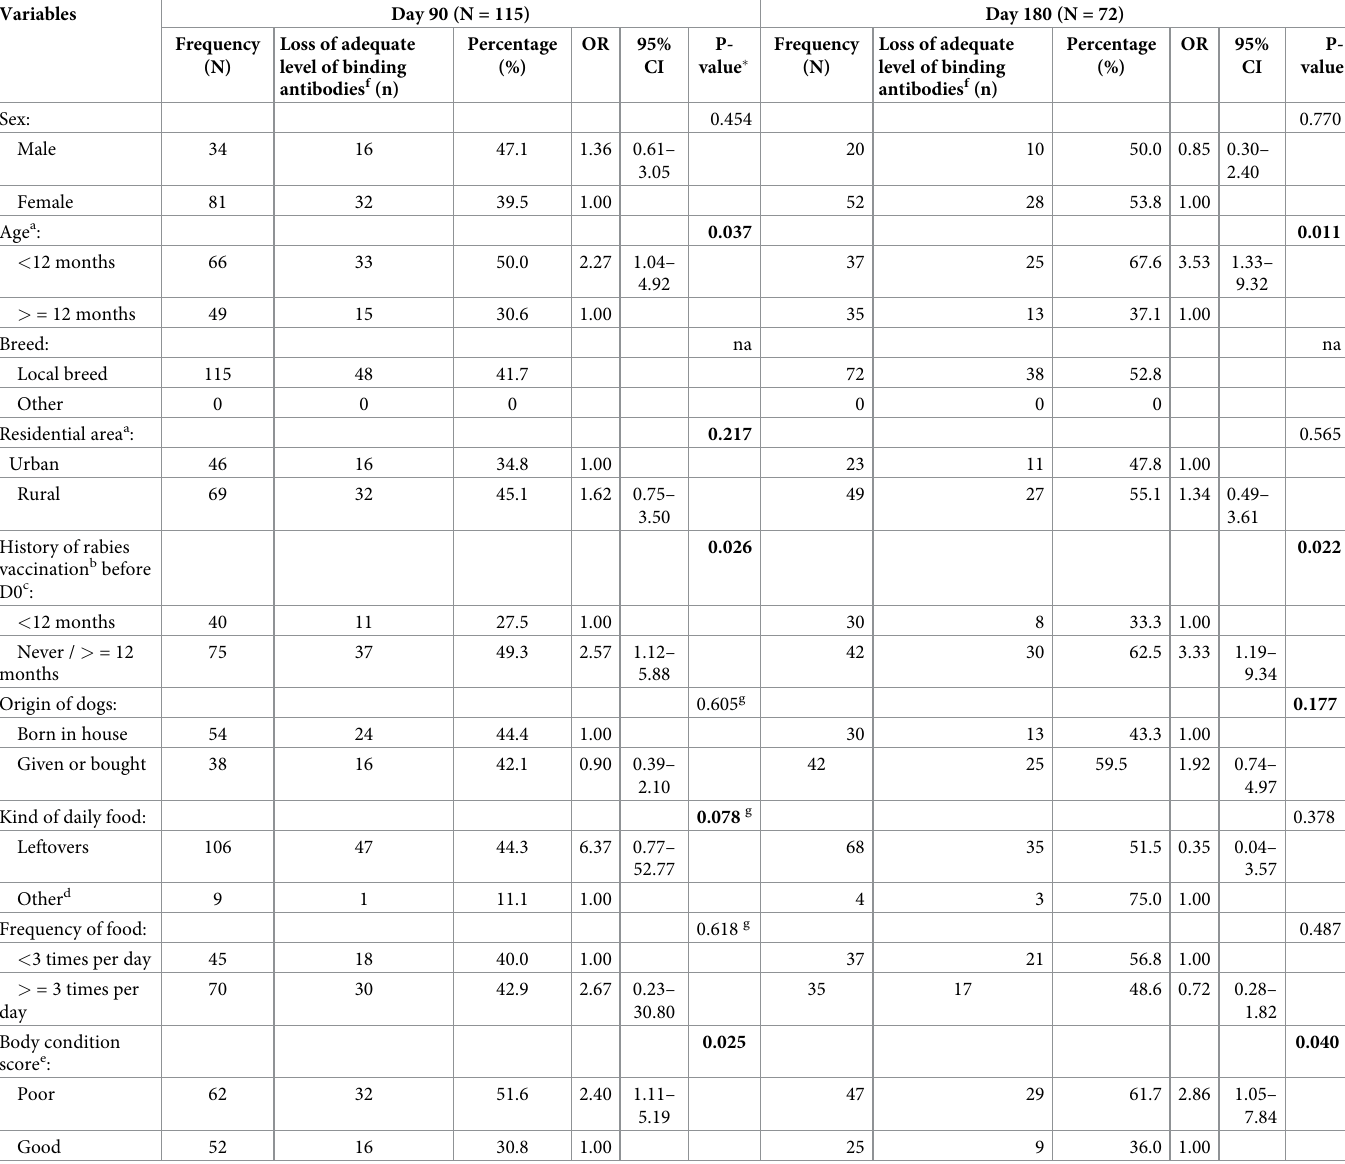
Table 2. Frequency (n) and percentage (n/N) of dogs losing adequate level binding antibodies 90 (D90) and 180 (D180) days after vaccination, stratified by different demographic characteristics of the dogs. The influence of demographic parameters were explored by univariable logistic regression analyses.